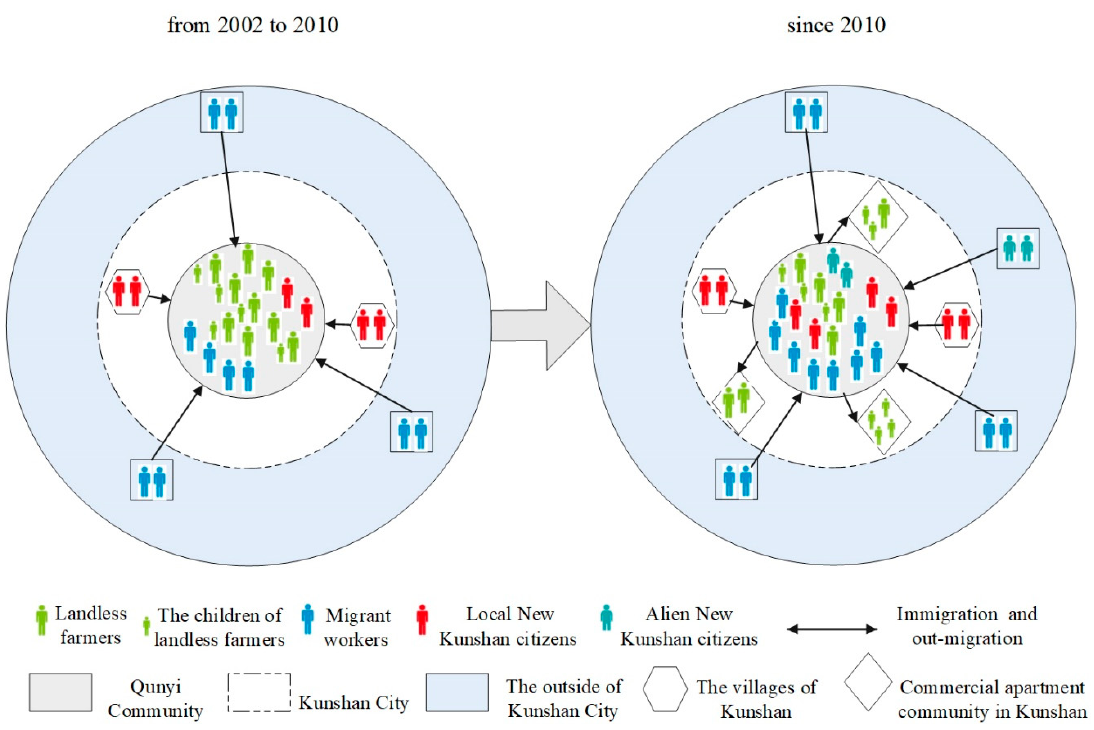
Figure 4. Evolution of the resident composition in Qunyi Community.